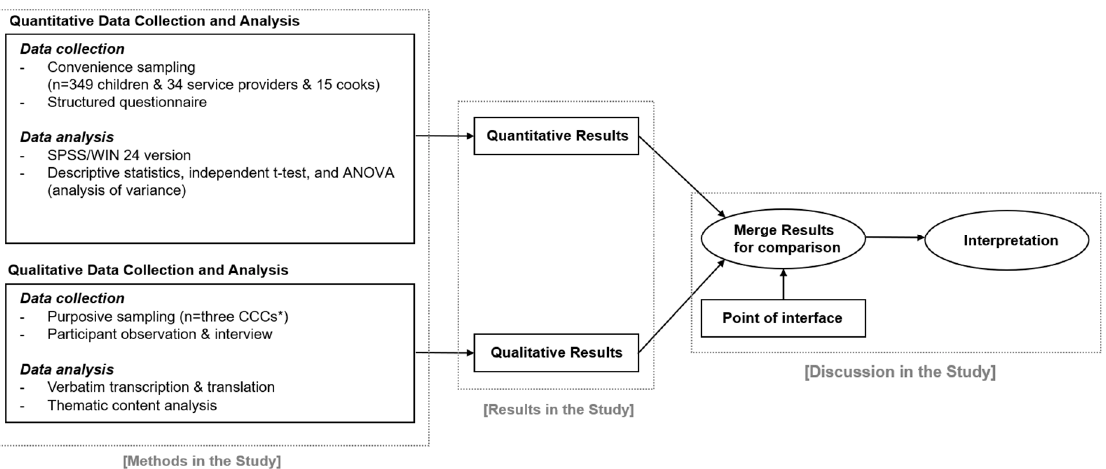
Figure 1. Research approach: Convergent parallel design [30]. * CCCs: Community Childcare Centers.